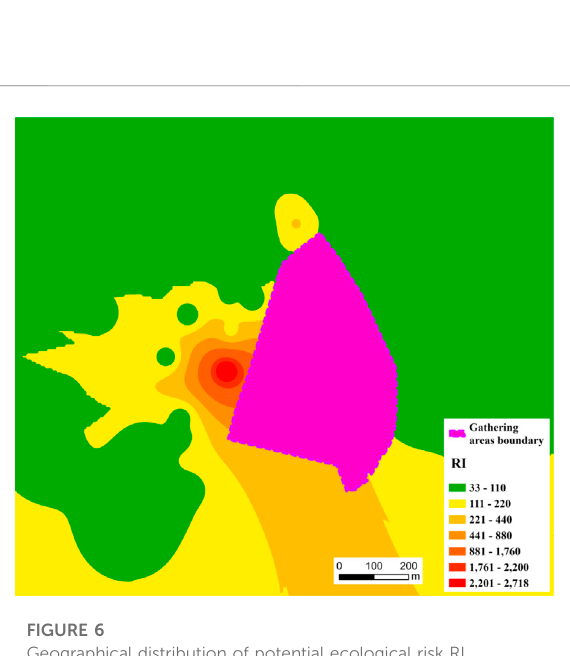
FIGURE 6 Geographical distribution of potential ecological risk